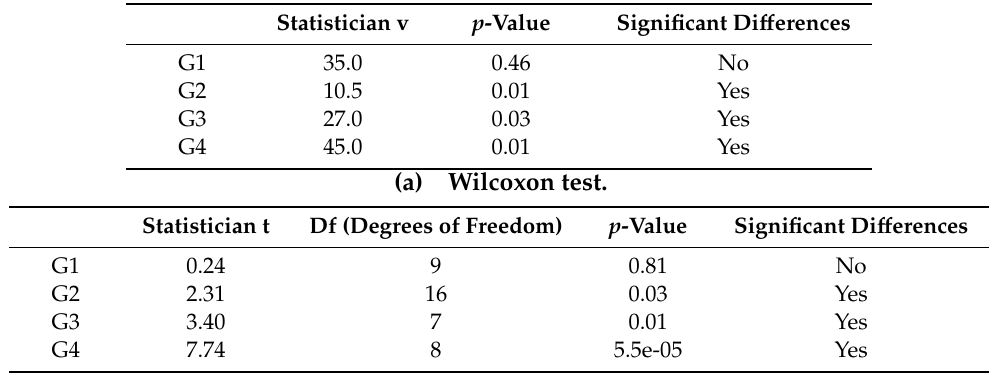
(b) Paired simple t test. Note: G1 ( n = 10); G2 ( n = 17); G3 ( n = 8); G4 ( n =